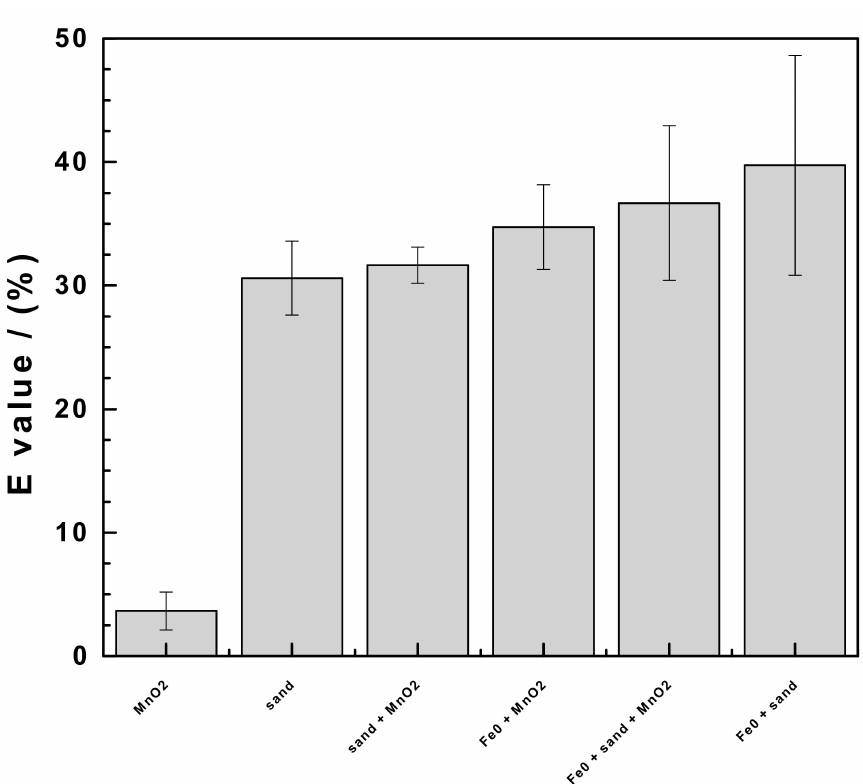
Figure 1. Comparison of the efficiency of tested materials for methylene blue (MB) discoloration for 7 days. Experimental conditions: [Fe 0 ] = 0 to 45 g L − 1; [sand] = 45 g L − 1; and [MnO 2 ] = 2.3 g L − 1, shaken intensity: 75